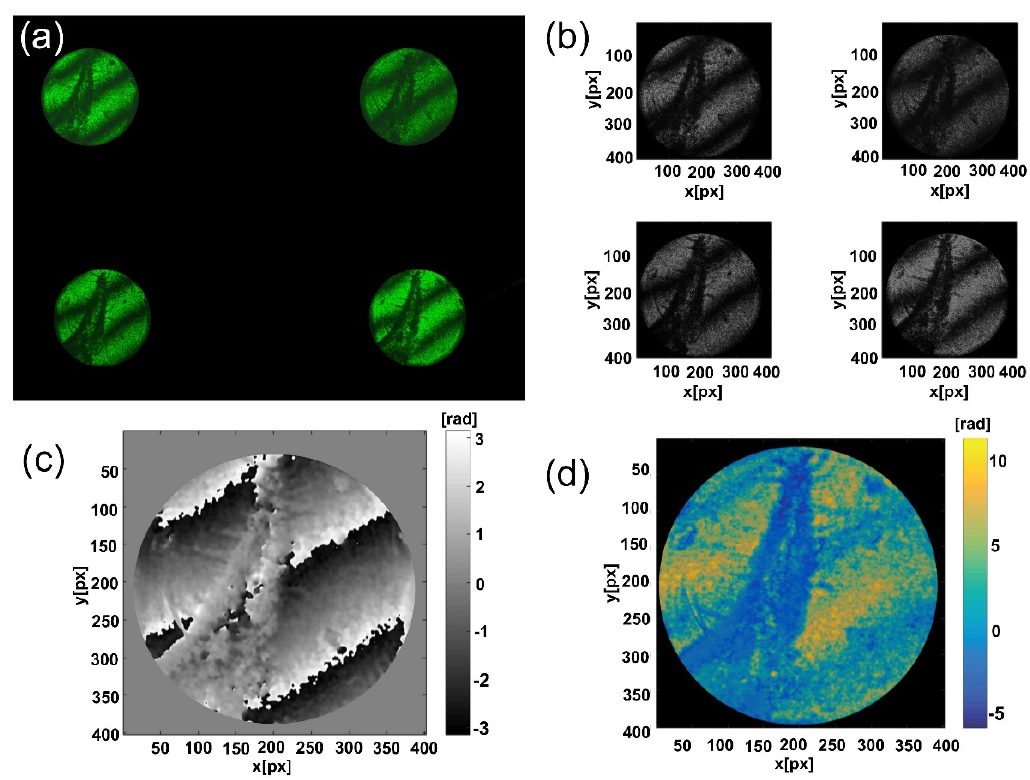
Figure 7. Pseudoscorpion claw. ( a , b ) Four simultaneous patterns. ( c ) Wrapped phase. ( d ) Phase map.